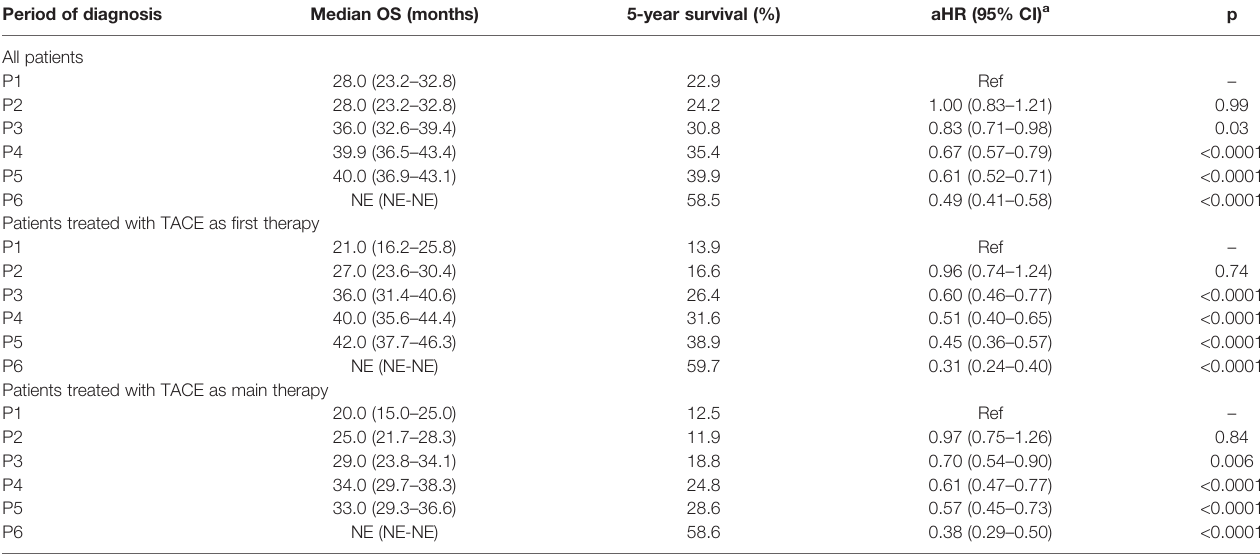
TABLE 4 | Survival analysis according to the period of diagnosis in the overall population of patients.